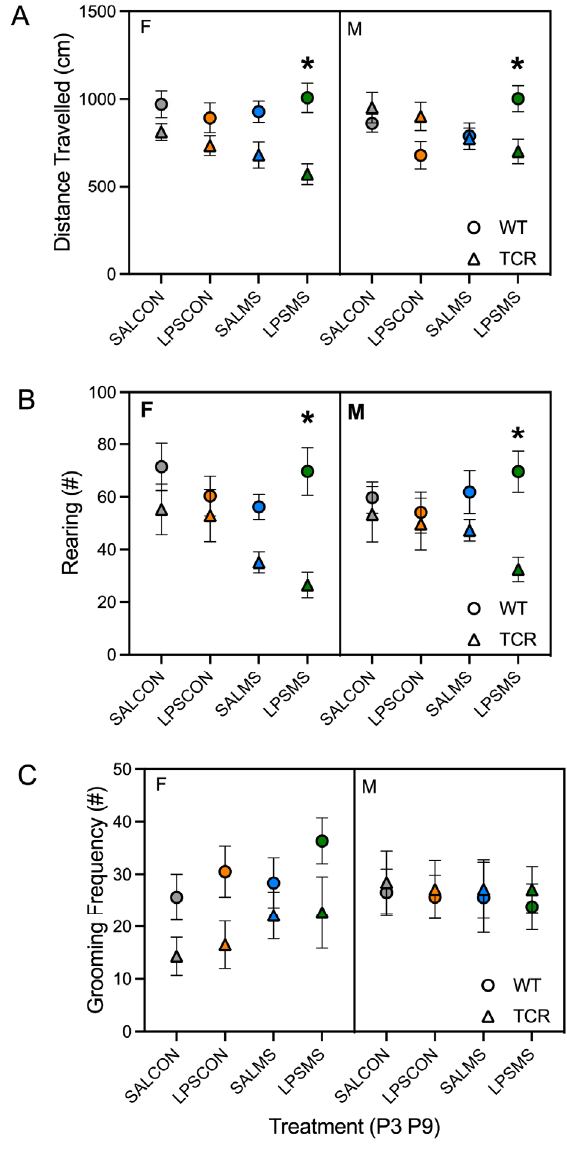
Figure 2. Behavioural comparison of wild-type (WT) and T-cell-deficient ( TCR β -/- δ -/- ) mice. Distance travelled ( A ) and rearing ( B ) measured in the open-field test at postnatal day 17 (P17) in female (F) and male (M) mice for different treatment conditions at P3 and P9—SALCON, SALMS, LPSCON, and LPSMS. Self-grooming was tested at P25 ( C ) * p < 0.05, mean ± S.E. provided, SAL, saline; LPS, lipopolysaccharide; CON, control; MS, maternal